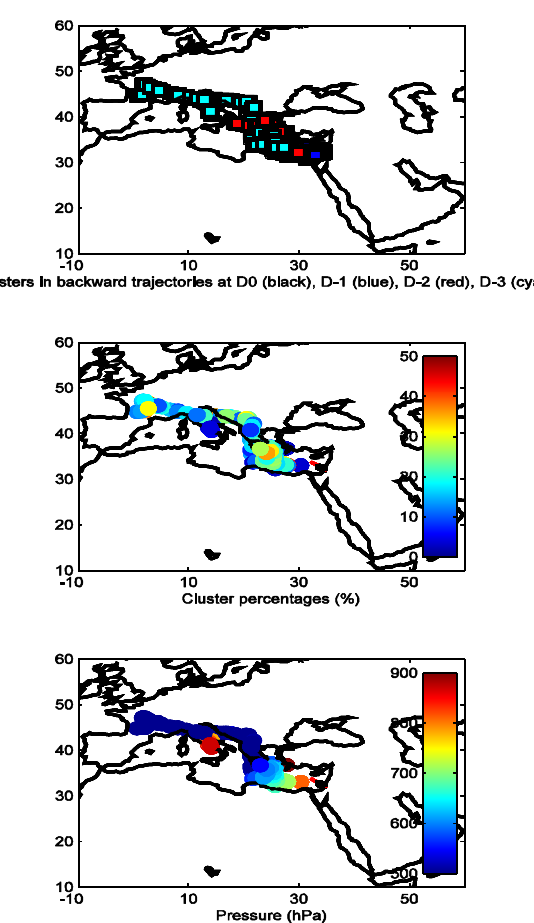
Fig. 7. Backward integration in time for 3 days for the MOZAIC vertical profile measurements and for air masses arriving at 1500– 5000m over Tel Aviv during a period with high ozone levels in the lower troposphere (31 July 2003, Flight: MD20030731102). The results are summarized on centroids of 5 clusters, and include latitude, longitude, pressure and percentage of representation every 12 hours. The results shown above are for the 1.5–5km layer. Top plot shows the clusters positions at day 0 (black), day-1 (blue), day-2 (red), and day-3 (cyan). Middle plot shows the percentages of clusters at day-3. Finally, bottom plot shows the pressure of the clusters at day-3. The red line is the aircraft trajectory during ascent/descent.